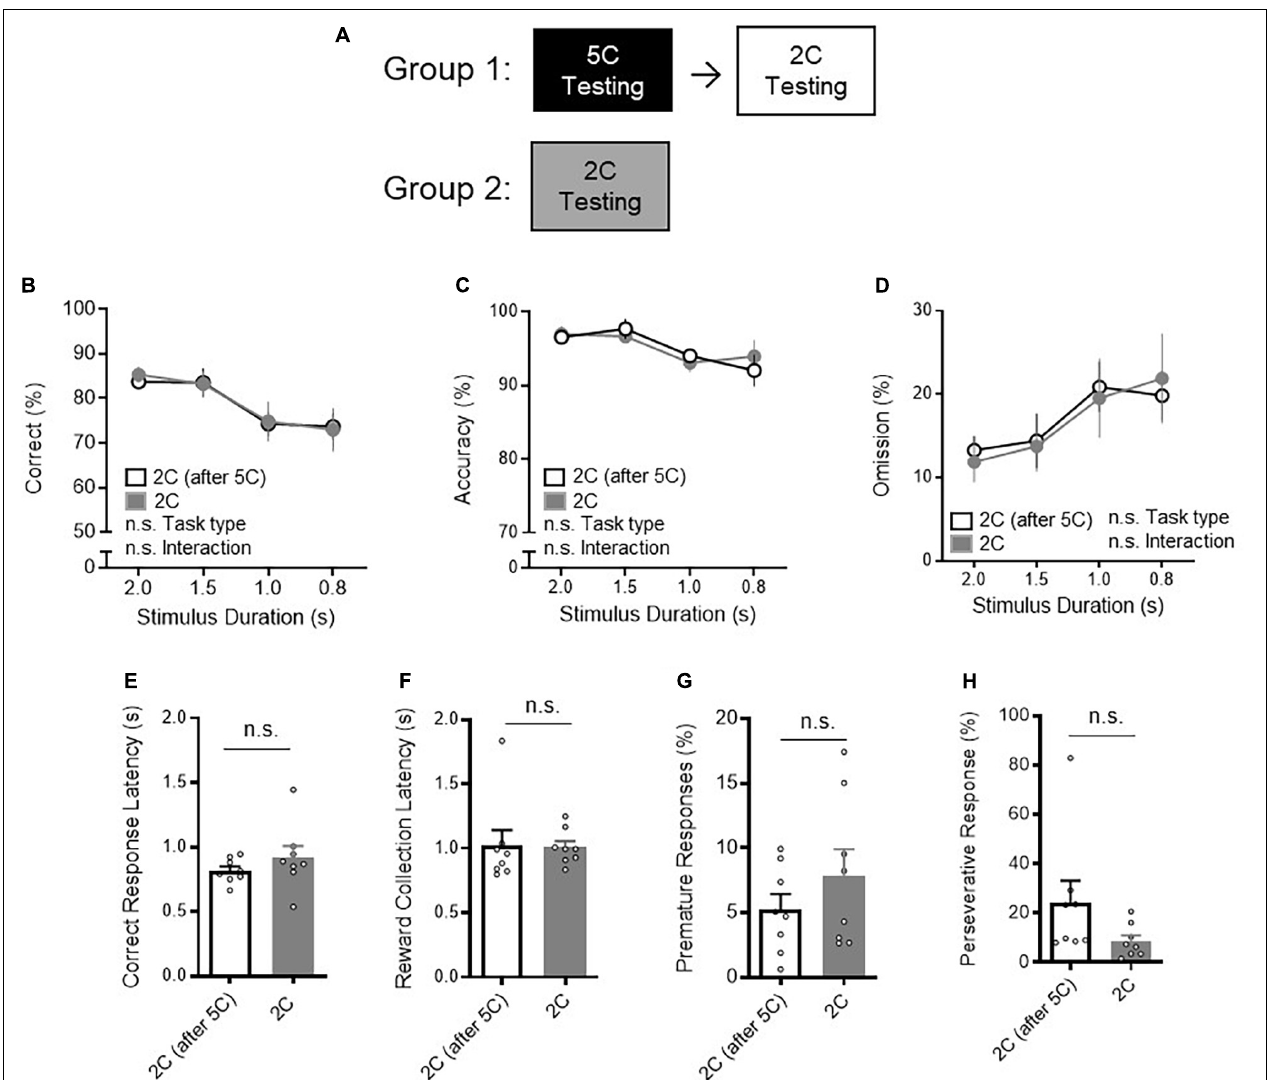
FIGURE 2 | Prior 5CSRTT performance has no effect on 2CSRTT performance. (A) The impact of prior 5CSRTT testing on 2CSRTT testing was examined. Group 1 trained and tested on the 5CSRTT and then next performed the 2CSRTT testing. Group 2 trained and tested the 2CSRTT, without prior 5CSRTT testing. (B) There was no difference in correct% during the 2CSRTT between mice with prior 5CSRTT testing ( n = 8 mice) and mice without 5CSRTT testing [ n = 8 mice, two-way RM ANOVA, Main effect (task type): F ( 1 , 14 ) = 0.006283, P = 0.9379, Main effect (stimulus duration): F ( 2 . 465 , 34 . 51 ) = 13, P < 0.0001, Interaction: F ( 3 , 42 ) = 0.1039, P = 0.9573]. (C) There was no difference in accuracy% during the 2CSRTT between mice with prior 5CSRTT testing and mice without 5CSRTT testing (two-way RM ANOVA, Main effect (task type): F ( 1 , 14 ) = 0.004251, P = 0.9489, Main effect (stimulus duration): F ( 3 , 42 ) = 5.225, P = 0.0037, Interaction: F ( 3 , 42 ) = 0.5455, P = 0.6539]. (D) There was no difference in omission% during the 2CSRTT between mice with prior 5CSRTT testing and mice without 5CSRTT testing [two-way RM ANOVA, Main effect (task type): F ( 1 , 14 ) = 0.006206, P = 0.9383, Main effect (stimulus duration): F ( 2 . 525 , 35 . 35 ) = 8.264, P = 0.0005, Interaction: F ( 3 , 42 ) = 0.3126, P = 0.8162]. (E–H) No difference in (E) correct response latency (t 14 = 1.049, P = 0.3119), (F) reward collection latency ( t 14 = 0.08138, P = 0.9363), (G) premature responses ( t 14 = 1.097, P = 0.2913), and (H) perseverative responses ( t 14 = 1.701, P = 0.1111) was observed between the two groups. Error bars indicate mean ± SEM. n.s.,